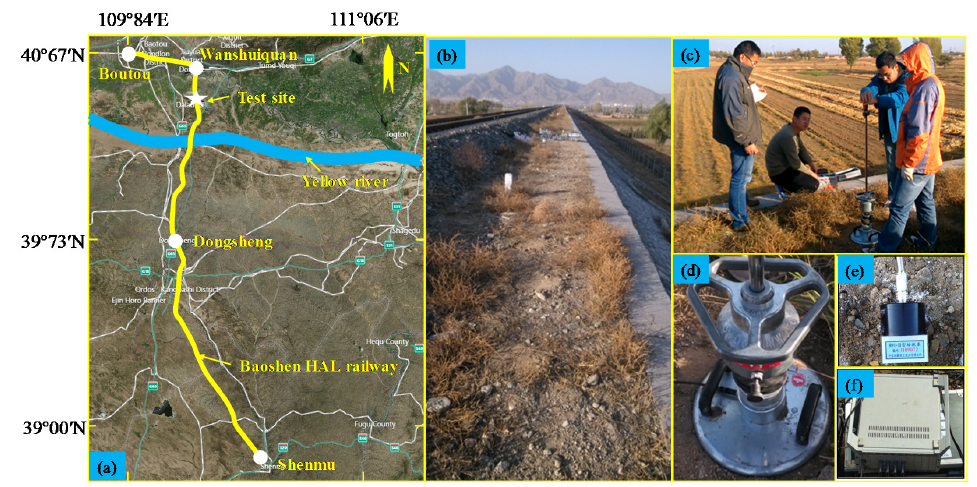
Figure 1. LFWD test plan: ( a ) location of the Baoshen heavy axle load (HAL) railway; ( b ) test site; ( c ) LFWD test; ( d ) LFWD device; ( e ) vibration pickup (891-II); and ( f ) data acquisition system (DH5922D).